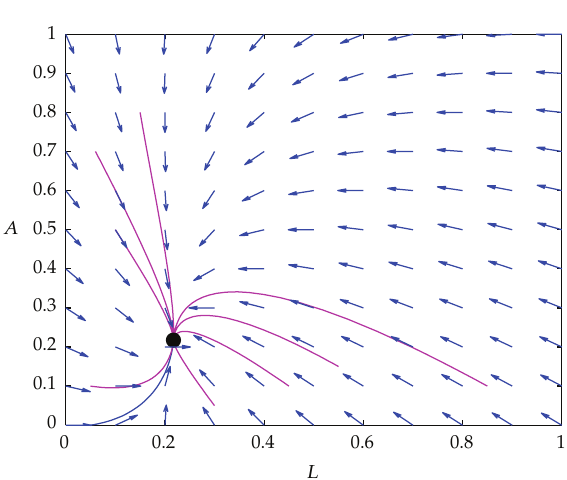
Figure 3: Phase portrait for the system given in Example 3.10.